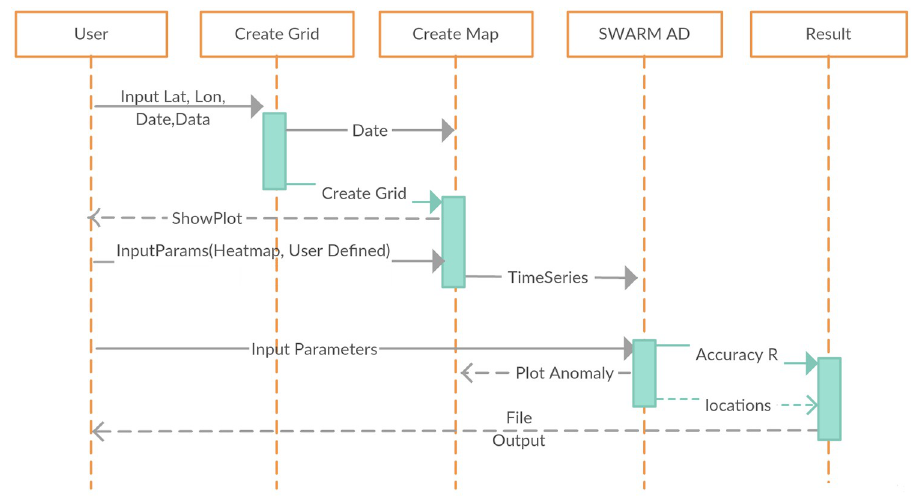
Fig 6. Sequence diagram of the proposed prototype.